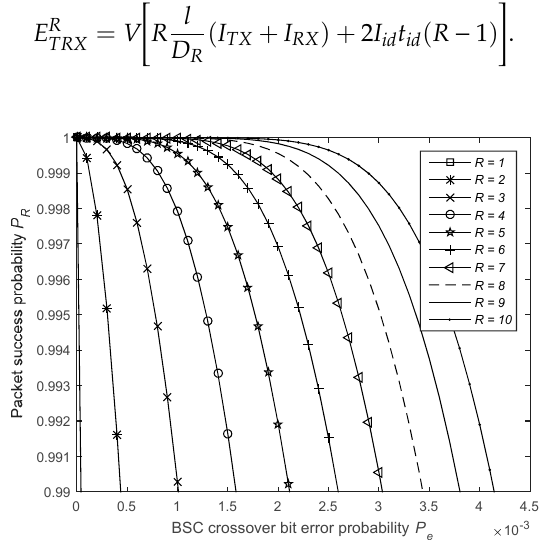
Figure 18. Impact of the number of blind transmission attempts on the packet success probability.